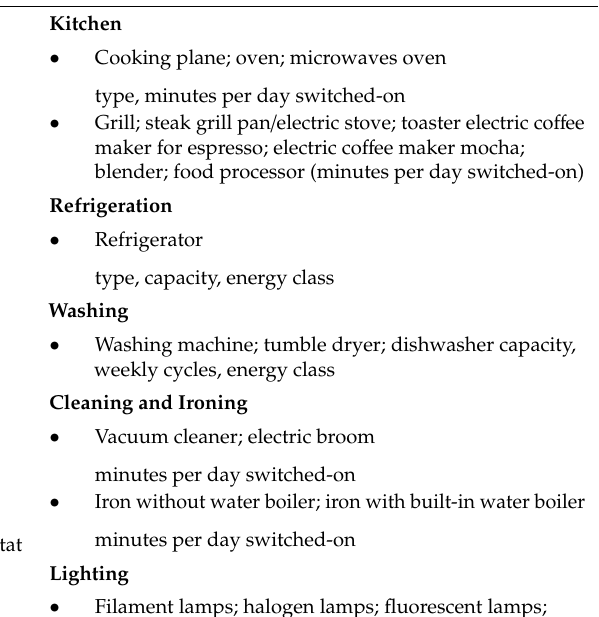
Table A1. Questionnaire